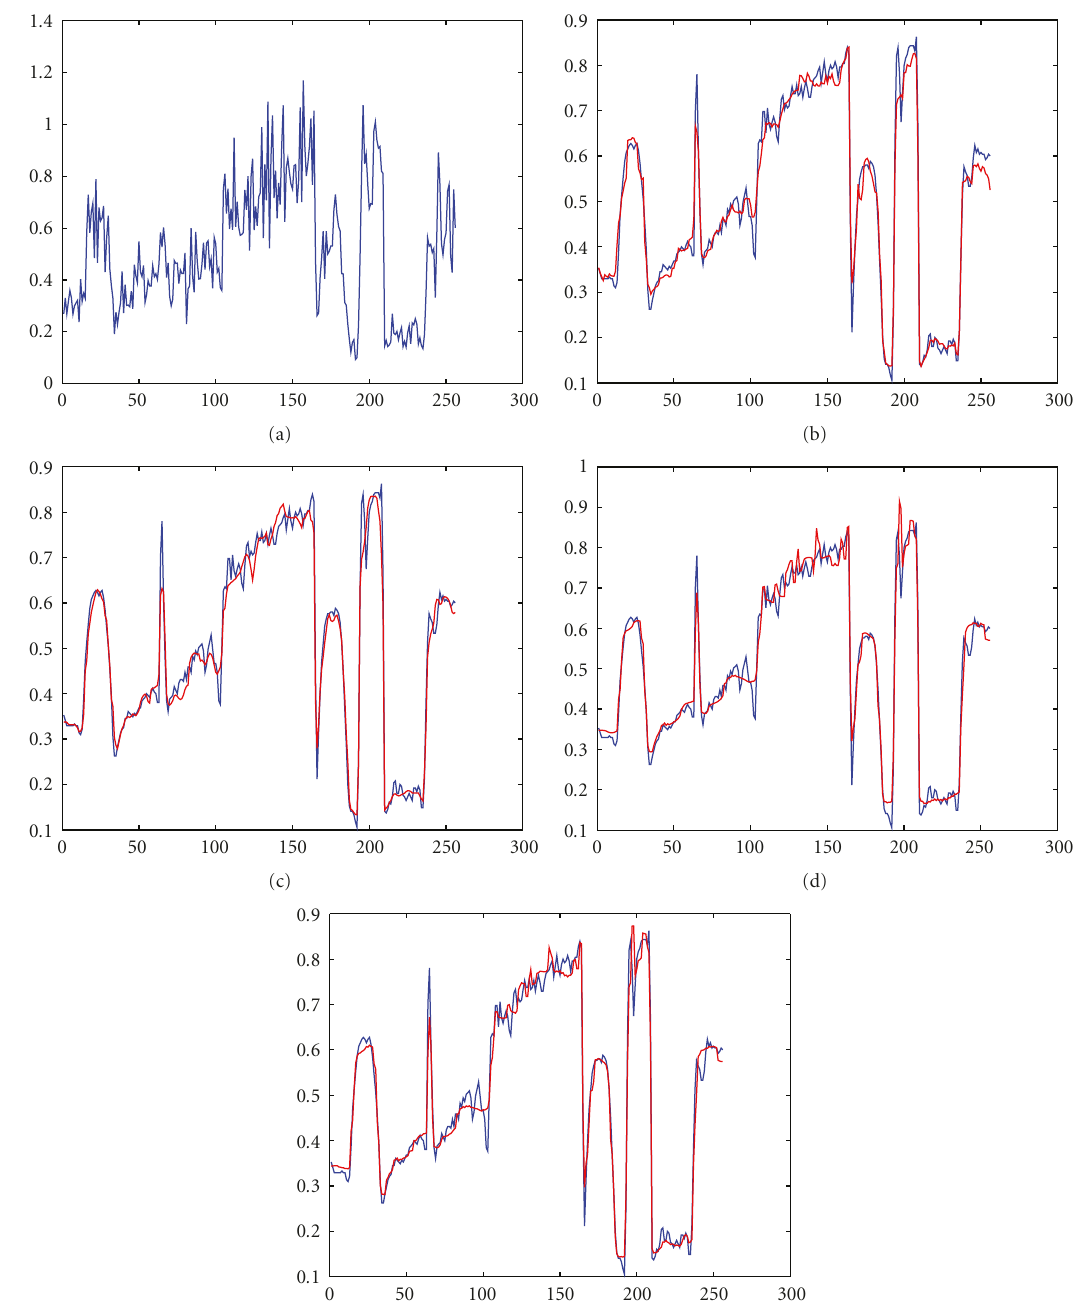
Figure 8: The 60th line of the original, noisy, and restored images for denoising Figure 2(a). (a) The noisy image; (b) the slice restored by the proposed method; (c) the slice restored by the “HMW” method; (d) the slice restored by the “AA” method; (e) the slice restored by the “RLO” method. Here the blue line is the original image, and the red line is the restored image.